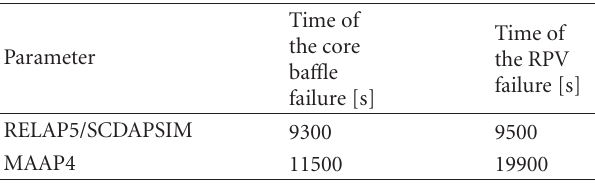
Table 2: Composition of molten material in the reactor vessel lower head, Group 1.